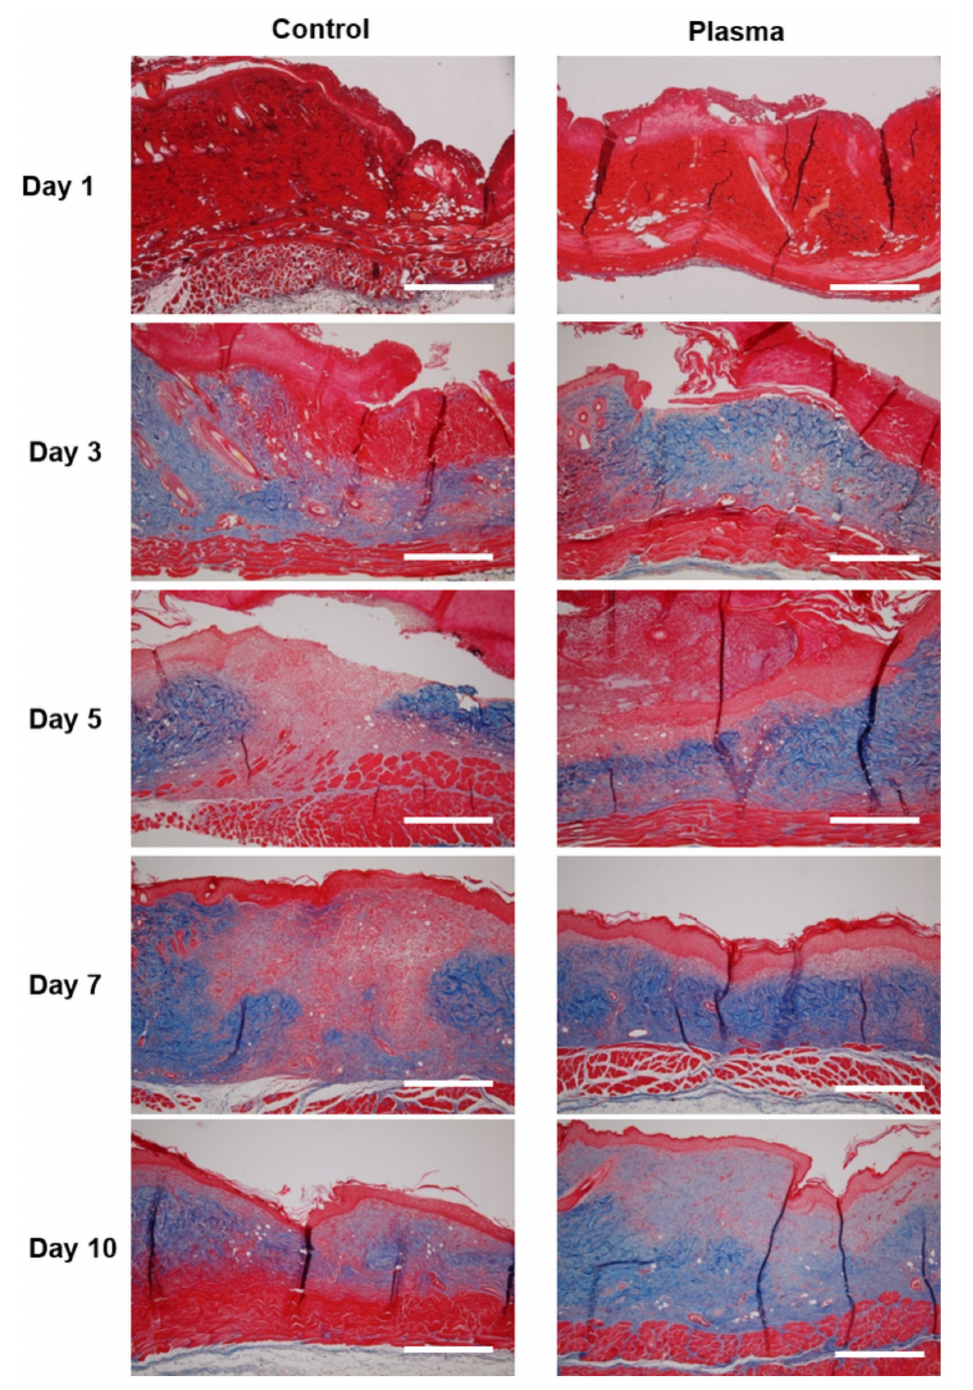
Figure 8. Representative histological analysis stained with Masson’s trichrome at the indicated time points. Collagen deposition (blue) was denser in the plasma-treated group after Day 3, as compared to the control. Original magnification × 10; scale bars = 500